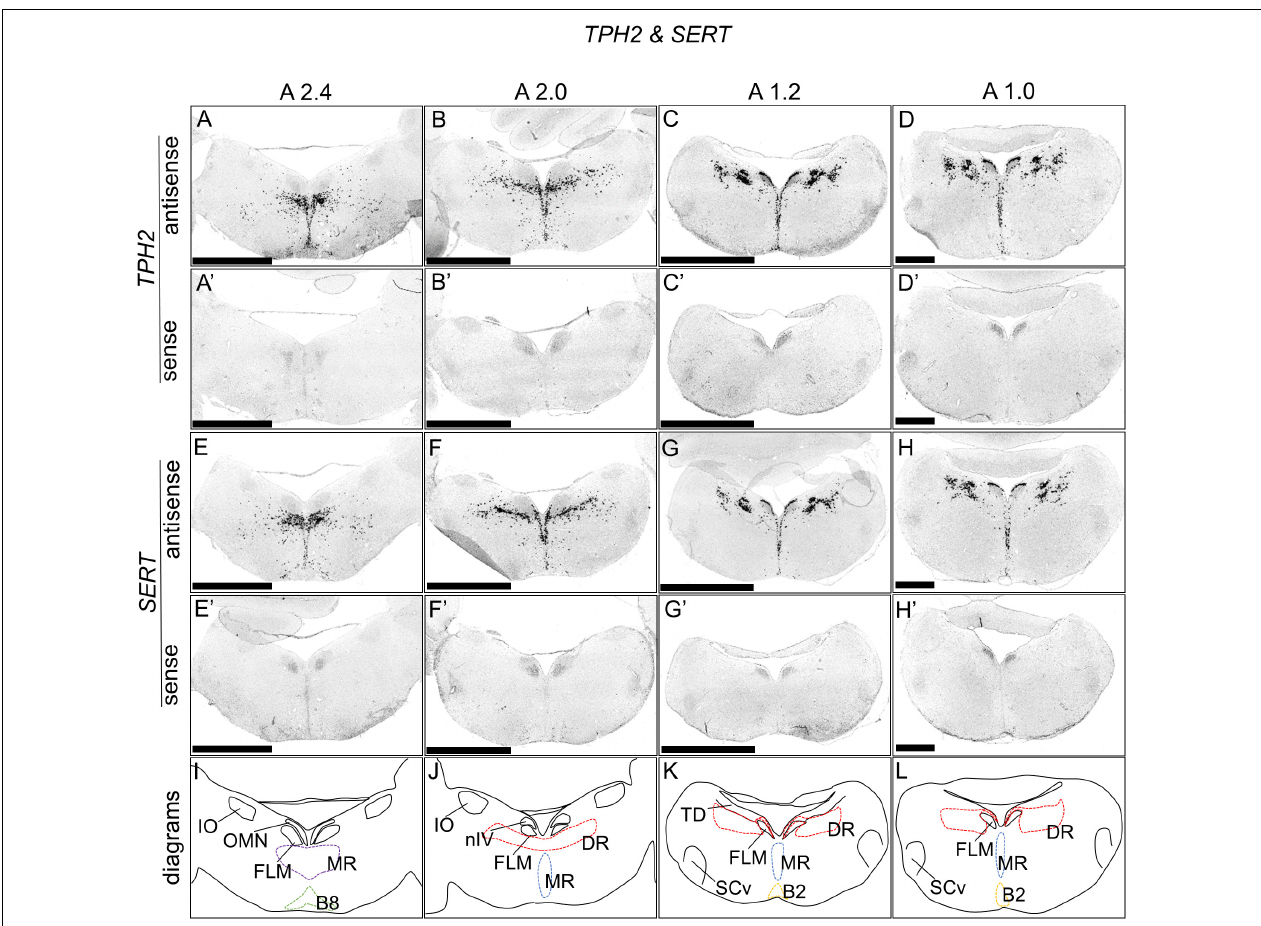
FIGURE 1 | In situ hybridization of TPH2 and SERT in the P1 chick brainstems. Digoxigenin-labeled RNA antisense [ TPH2 (A–D) , and SERT (E–H) ] and sense [ TPH2 (A’–D’) and SERT (E’–H’) ] probes were used for in situ hybridization in P1 chick brain coronal sections. To evaluate the expression patterns of TPH2 and SERT , sections of six chicks for TPH2 and four chicks for SERT were analyzed, and the representative levels of sections (A2.4, A2.0, A1.2, and 1.0) are shown. The levels of the sections are in accordance with those mentioned in Kuenzel and Masson’s chick atlas (Kuenzel and Masson, 1988). (I–L) Diagrams of coronal sections shown in panels (A–D) . B2, B2 cell group; B8, B8 cell group; DR, dorsal raphe; FLM, fasciculus longitudinalis medialis; IO, nucleus isthmo-opticus; MR, median raphe; nIV, nucleus nervi trochlearis; OMN, oculomotor nucleus; SCv, nucleus suboeruleus ventralis; P1, post-hatch day 1. Scale bars = 2.5 mm (A–C,A’–C’) and 1 mm (D,D’,H,H’)